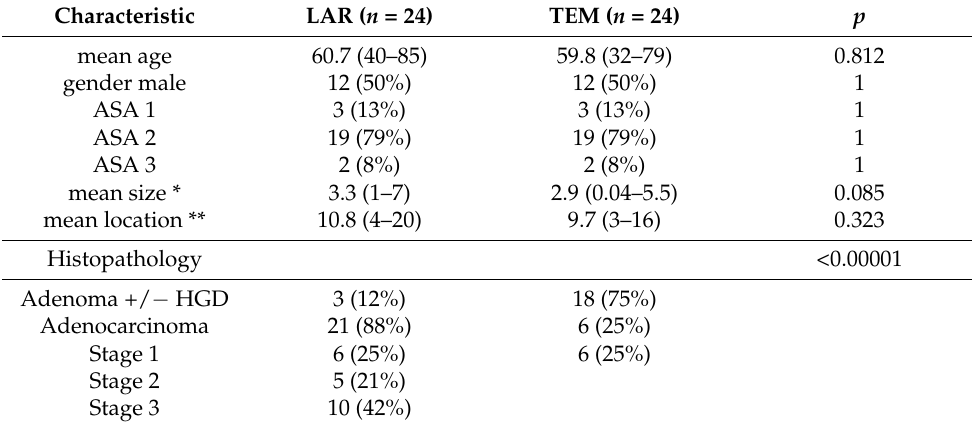
Table 1. Patient and lesion